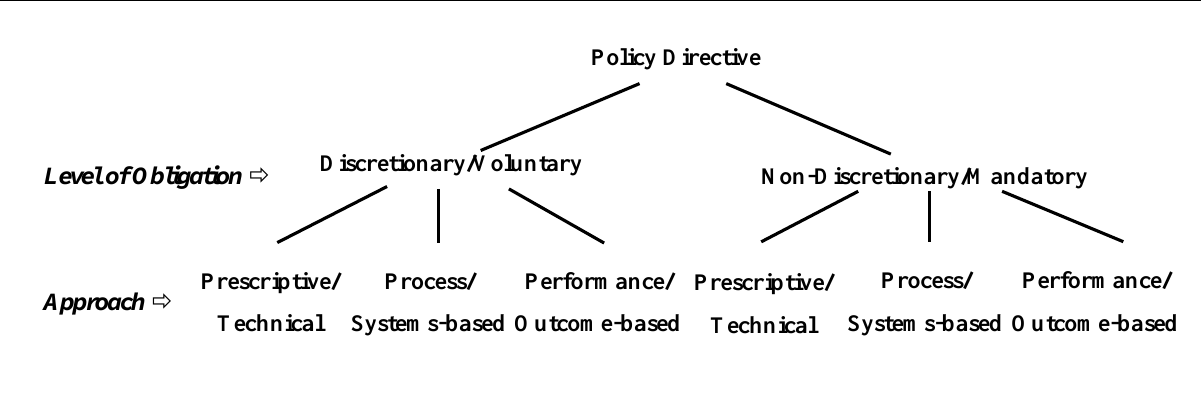
Figure 1. Policy Structure by Level of Obligation and Approach (Adapted from: Gunningham and Grabsoky 1998 [18]; Bluff and Gunningham 2003 [22]; Cashore and McDermott 2004